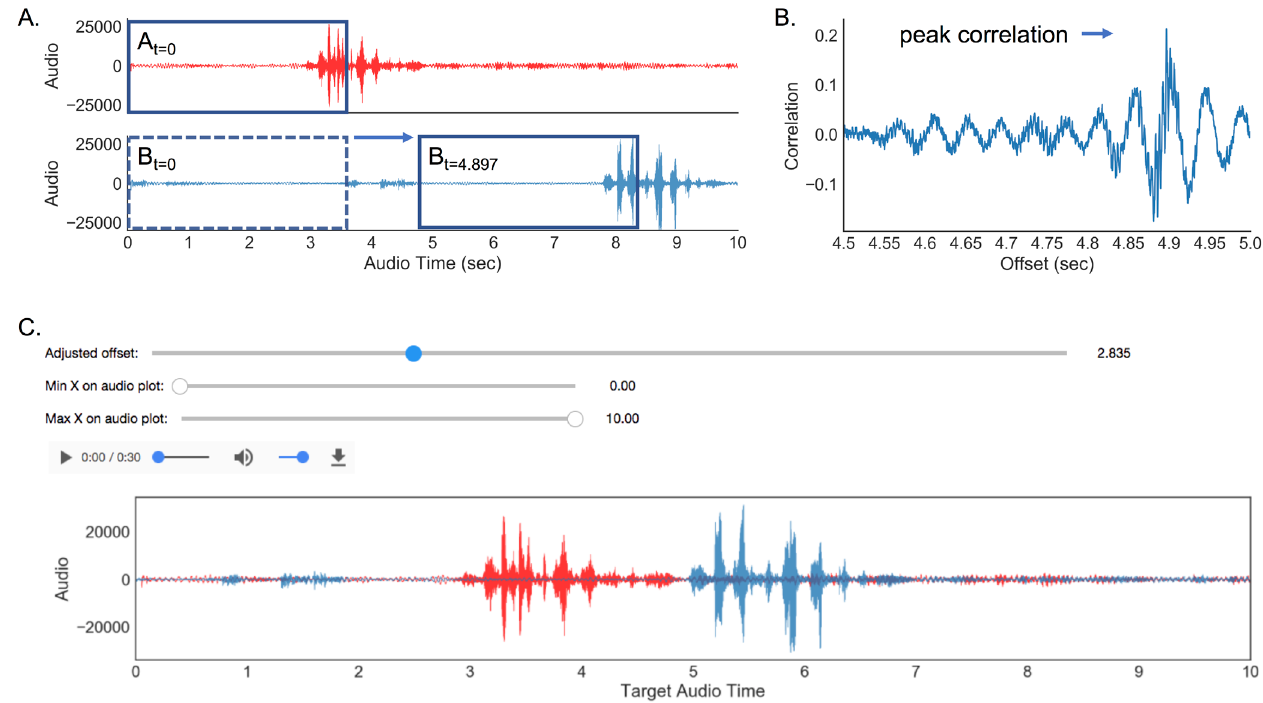
Figure 2. Schematic of automatic and manual audio alignment method. ( A , B ) Portion of audio is selected from target audio (red waveform top panel) which is compared to a portion of the sample audio selected in a sliding temporal window (blue waveform bottom panel). Correlation similarity is calculated at each window and the offset is determined to be the temporal window that maximizes similarity between the two audios. ( C ). Graphical interface in FaceSync toolbox to manually align two audios. One audio file can be shifted in time using the sliders until the two waveforms are aligned. Alignment can be inspected visually by examining the waveform plots and by listening to the combined